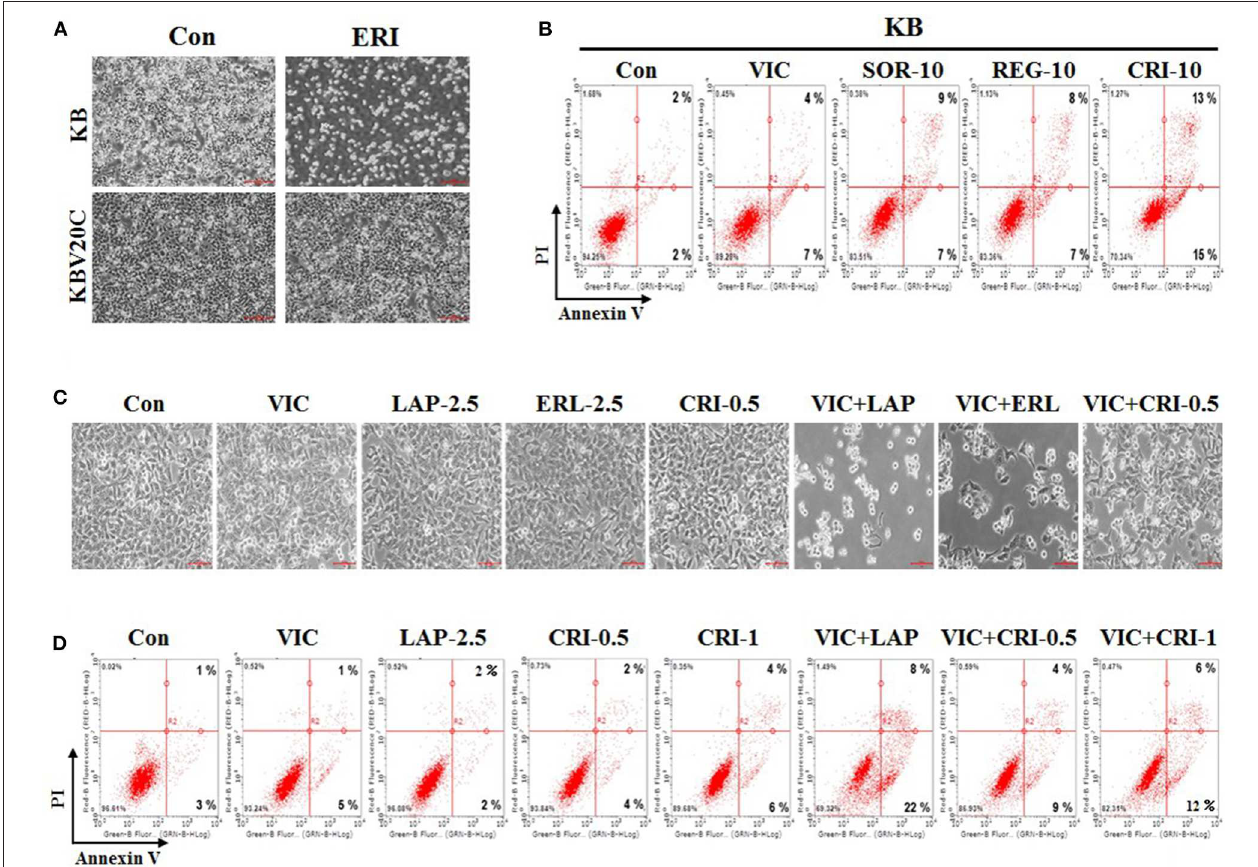
FIGURE 3 | Low-dose crizotinib specifically sensitizes drug-resistant KBV20C cells more than drug-sensitive parent KB cells. (A) Parent sensitive KB cells and drug-resistant KBV20C were grown on 60 mm-diameter dishes and treated with 30nM eribulin (ERI) or 0.1% DMSO (Con). After 1 day, all cells were observed using an inverted microscope at × 4 magnification. (B) Parent sensitive KB cells were grown on 60 mm-diameter dishes and stimulated with VIC, 5nM vincristine; SOR-10, 10 µ M sorafenib; REG-10, 10 µ M regorafenib; CRI-10, 10 µ M crizotinib; or 0.1% DMSO (Con). After 24h, annexin V analyses were performed as described in Materials and Methods. (C,D) KBV20C cells were grown on 60 mm-diameter dishes and stimulated with VIC, 5nM vincristine; LAP-2.5, 2.5 µ M lapatinib; ERL-2.5, 2.5 µ M erlotinib; CRI-0.5, 0.5 µ M crizotinib; CRI-1, 1 µ M crizotinib; VIC + LAP, 5nM vincristine with 2.5 µ M lapatinib; VIC + ERL, 5nM vincristine with 2.5 µ M erlotinib; VIC + CRI-0.5, 5nM vincristine with 0.5 µ M crizotinib; VIC + CRI-1, 5nM vincristine with 1 µ M crizotinib; or 0.1% DMSO (Con). After 24h all cells were observed using an inverted microscope at × 10 magnification (C) , or annexin V analyses were performed as described in Materials and Methods (D)